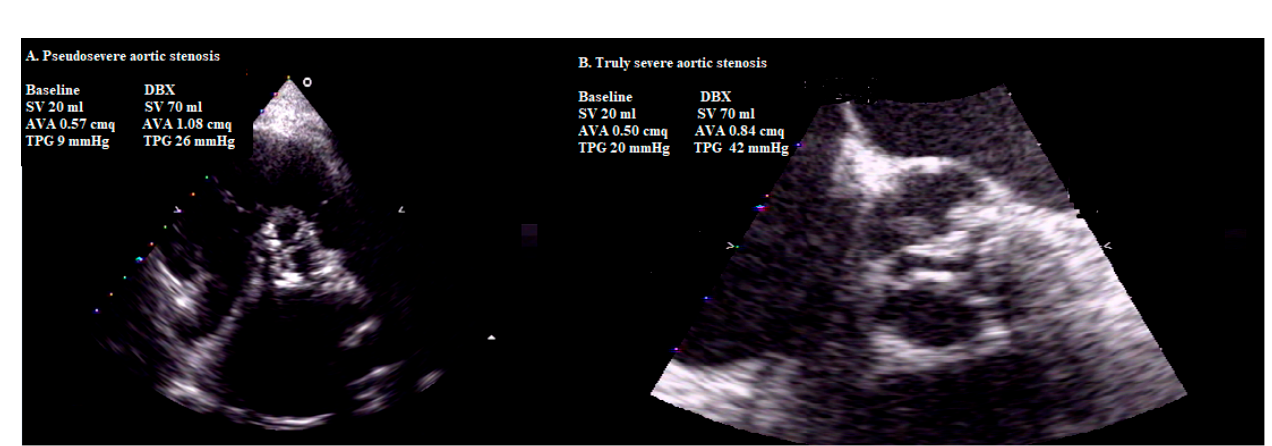
Figure 3. The figure shows the case of valve with pseudo ‐ severe aortic stenosis ( A ) at low (rest) and normal flow rate (dobutamine) and that of valve with truly severe aortic stenosis ( B ) at low and normal flow rate. SV: stroke volume; AVA: aortic valve area; TPG: transvalvular pressure gradient. DBX: Dobutamine. See the text for details. A projected AVA ≤ 1 cm 2 is considered severe. In many ways, the concept of projected AVA outperforms the traditional flow ‐ reserve concept, which may be intrinsically flawed due to the complex interaction between decreased contractility, increased afterload and altered geometry in classical LF ‐ LG AS [38]. However, many patients with paradoxical LF ‐ LG AS have small ventricles, with concentric remodeling and a high prevalence of atrial fibrillation and isolated upper septal hypertrophy, which may lead to serious side effects such as LVOT dynamic obstruction with hypotension and syncope; thus, DSE should be stopped as soon as increase in flow is